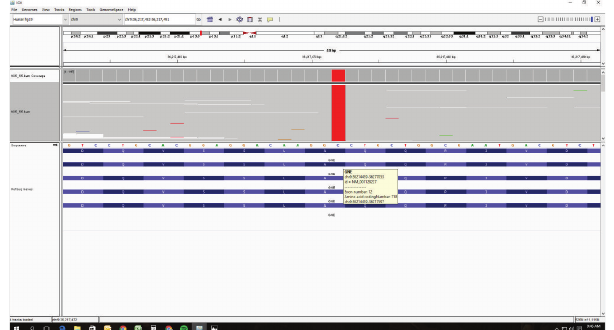
Figure 2: The homozygous GNE gene mutation in both sisters.